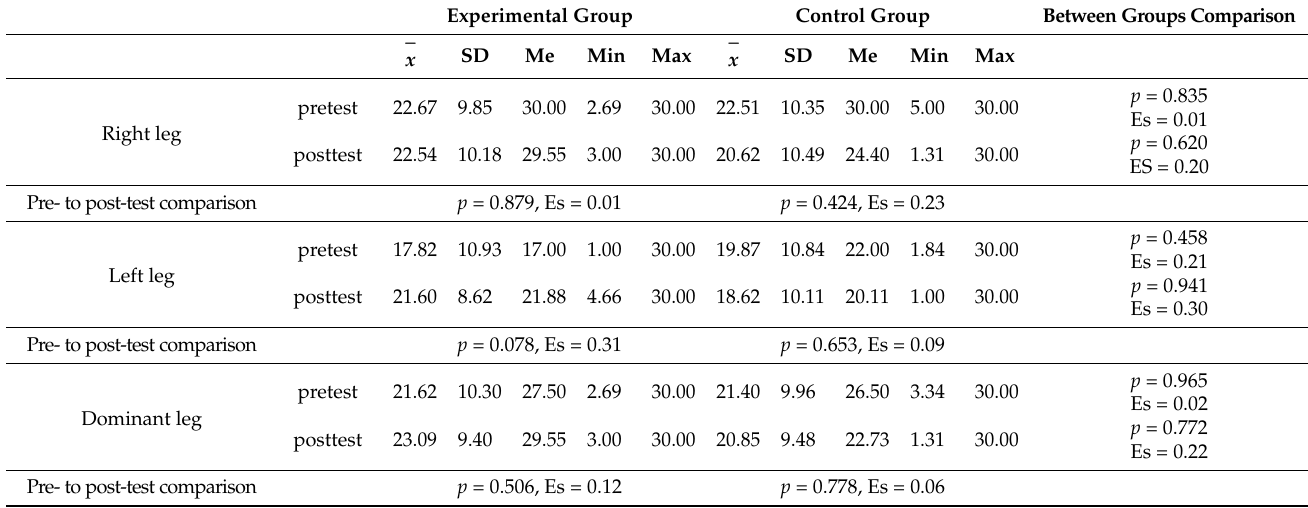
Table 3. One Leg Stance Test (OLST) results for the experimental and control